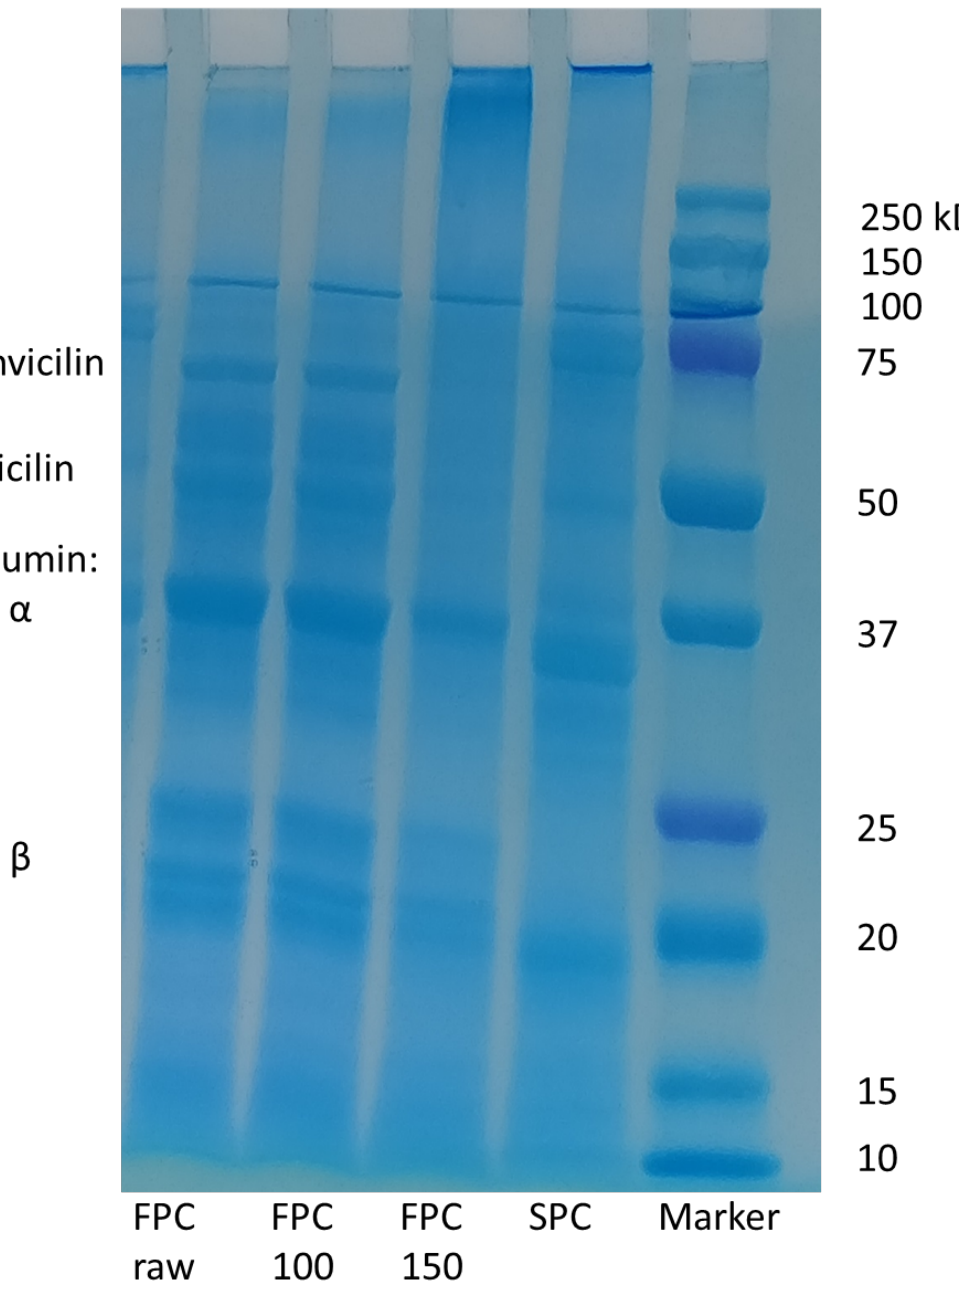
Figure 4. SDS-PAGE of non-dry-heated and dry-heated FPC. SPC is shown as a reference. Non-dry-heated and dry-heated at 100 ◦ C FPC showed bands for convicilin, vicilin, α -legumin, and β -legumin. FPC dry-heated at 150 ◦ C showed the legumin bands less pronounced, while the vicilin and convicilin bands were not detectable. Instead, indistinguishable bands larger than 250 kDa appeared. For soy, the subunits for glycinin and β -conglycinin were